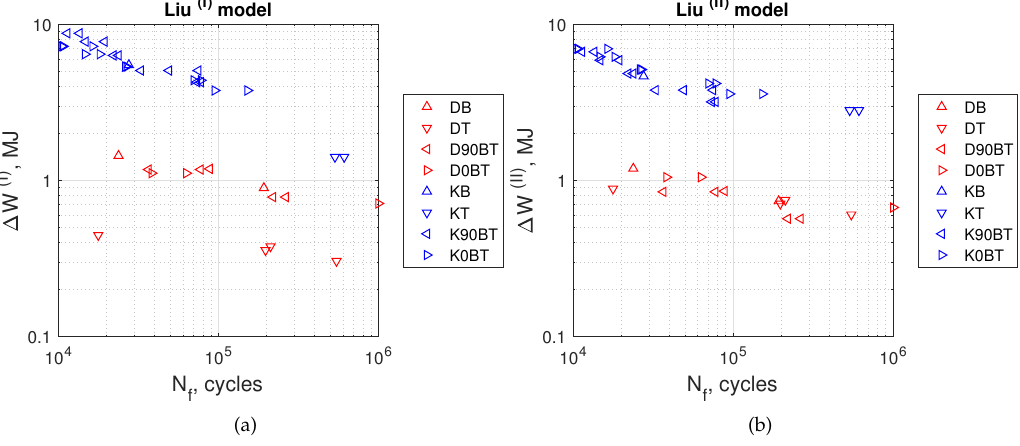
Figure 14. ( a ) Liu ( I ) model Equation (7), ( b ) Liu ( II ) model Equation (8). Tests at kinematic load: K90BT, out of phase; K0BT, in phase; KB, bending; KT, torsion. Dynamic loads: D90BT, out of phase; D0BT, in phase; DB, bending; DT,